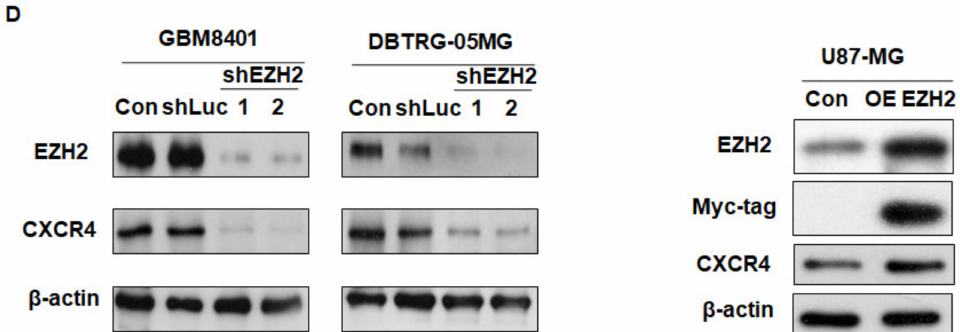
Figure 2. Upregulation of CXCR4 expression by EZH2. ( A ) Di ff erential expression of EZH2 and CXCR4 mRNA in U87-MG, GBM8401, and DBTRG-05MG cells. The expression of EZH2 and CXCR4 was determined using qRT-PCR. ( B ) Western blot analysis of EZH2, CXCR4, and actin (loading control) in whole-cell lysates. ( C ) The e ff ect of shEZH2 or Myc-EZH2 on mRNA expression in GBM8401, DBTRG-05MG, and U87-MG cells was evaluated using qRT-PCR. CXCR4 mRNA expression is shown relative to control. ( D ) Western blot analysis of EZH2 and CXCR4 in EZH2 knockdown / overexpression (OE) GBM cells. (mean ± SD, n = 3). * p < 0.05. The raw data of Western blots is shown in Figure S1.